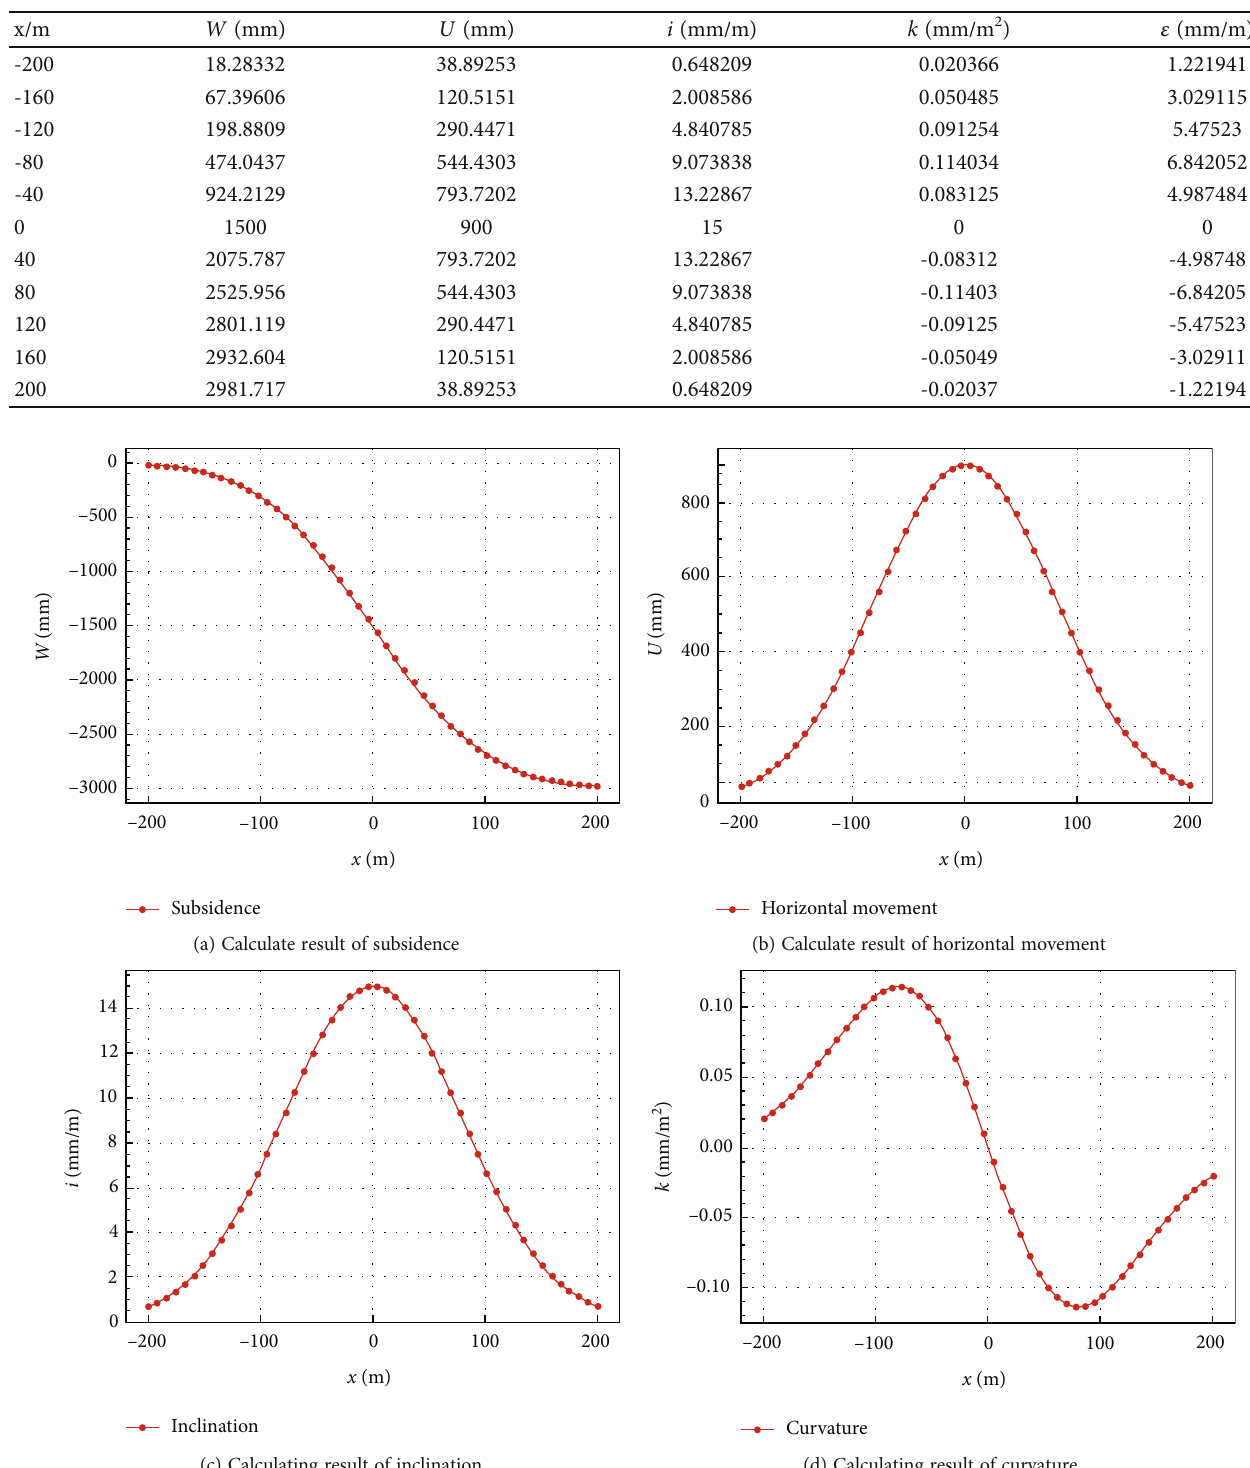
Table 1: Calculation results of case